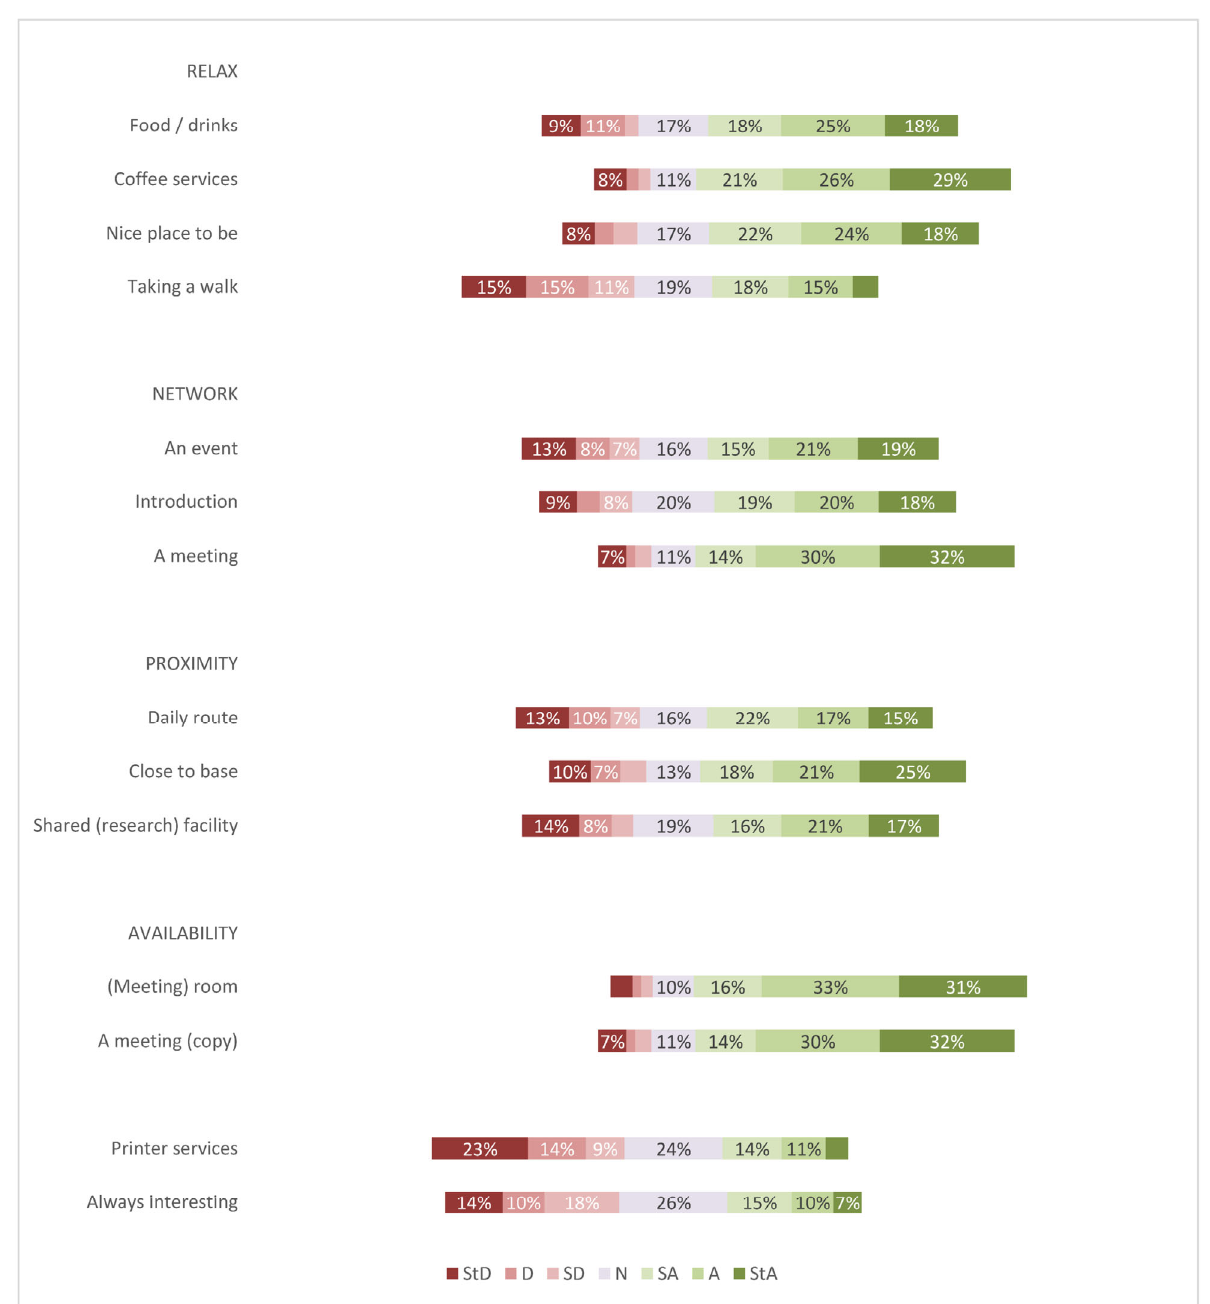
Figure A11. Likert scale 1–7 scores for services. StD = strongly disagree, D = disagree, SD = slightly disagree, N = neutral, SA = slightly agree, A = agree, StA = strongly agree.